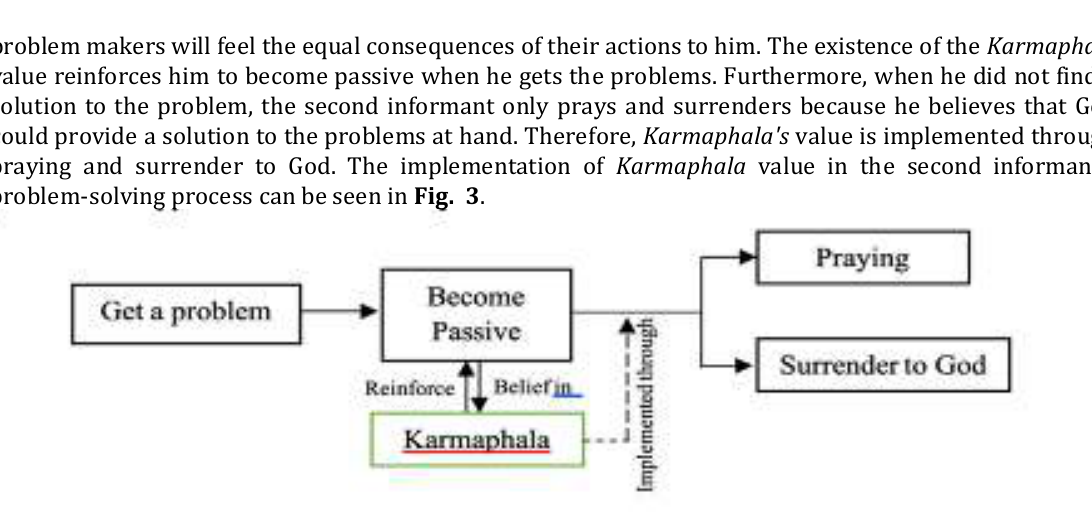
Fig. 3 The implementation process of Karmaphala value in Second Informant’s